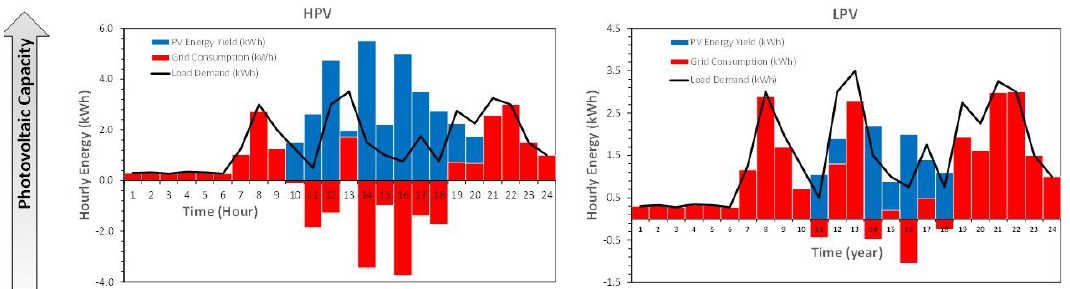
Figure 8. Daily energy balances according to the PV system size for Case 0.